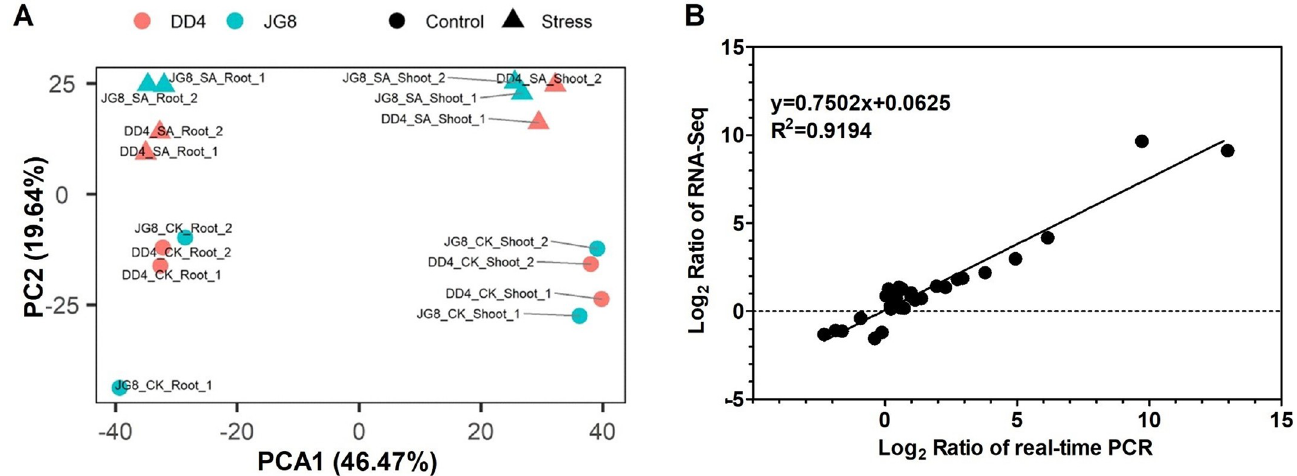
Fig 1. Verification of RNA-Seq results through (A) principal component analysis and (B) real-time PCR. Correlation between data obtained from RNA-Seq and RT-PCR data. Data are the mean of three biological replicates.